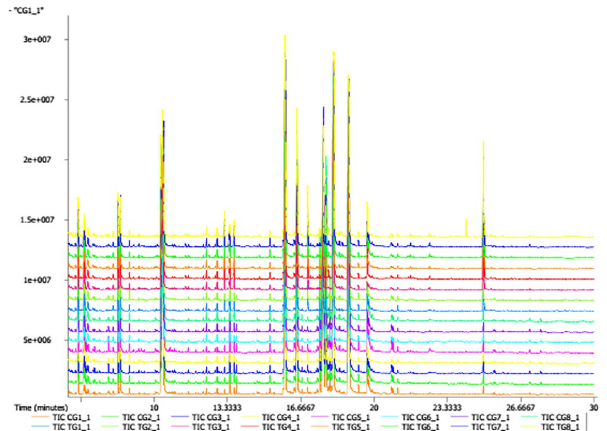
Figure 4. GC-TOF/MS TIC chromatograms of YC-WM1 with and without nicosulfuron exposure (TIC TG and TIC